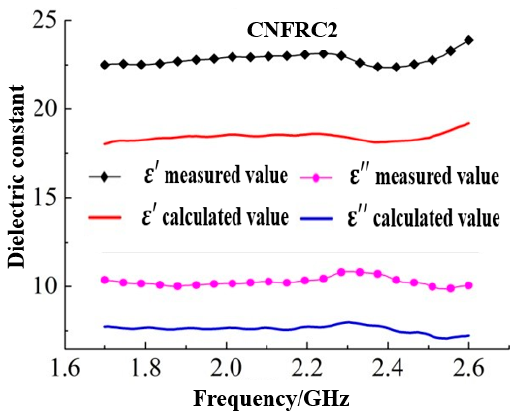
Figure 9. Results of dielectric constants calculated based on Looyenga model.